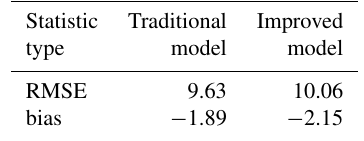
Table 8. Statistics of two models’ average accuracy of SWVs for the experimental period (unit: